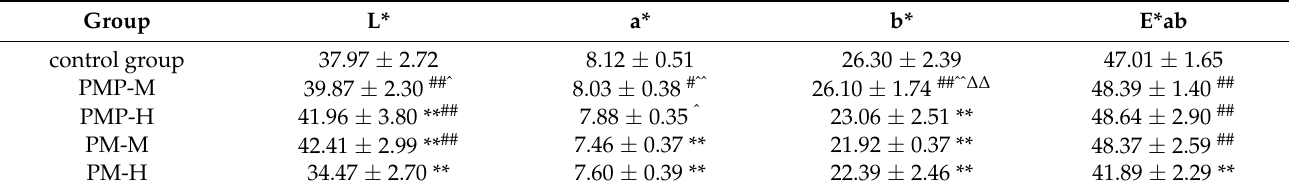
Table 2. Fecal chroma value after administration (x ± s).